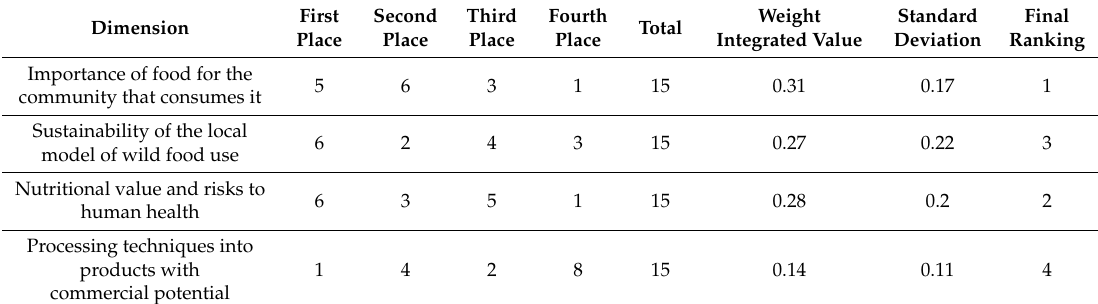
Table 2. Global preference order of the dimensions according to the experts’ individual